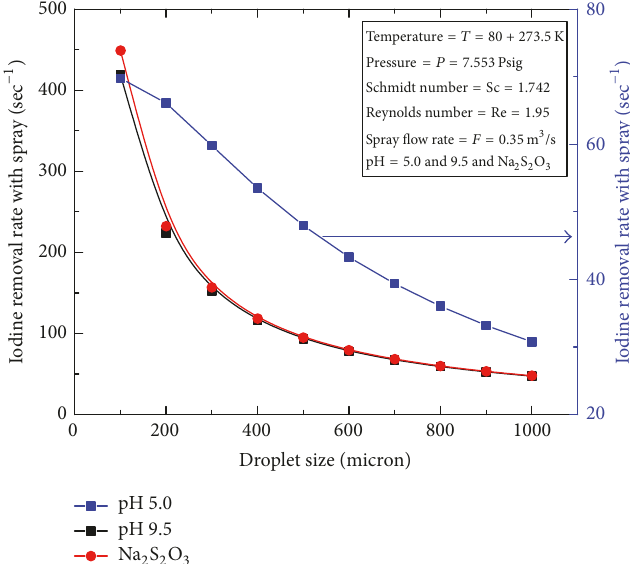
Figure 14: Droplet removal rate for iodine at pH 5.0 and 9.5 and with alkaline spray solution (Na 2 S 2 O 3 ).